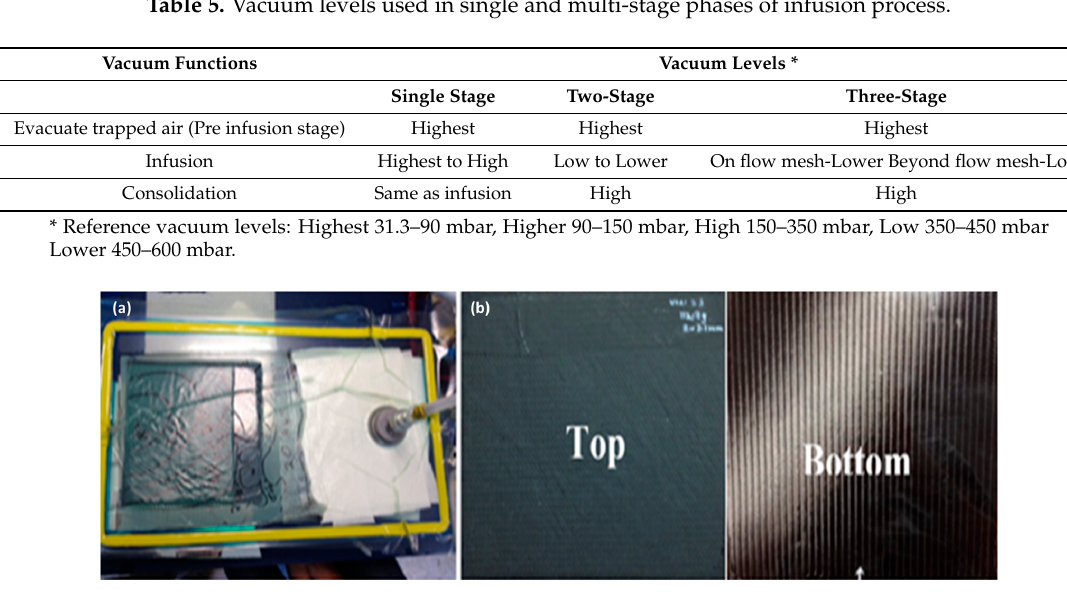
Table 4. Effect of flow mesh length on preform infusion at single stage vacuum.